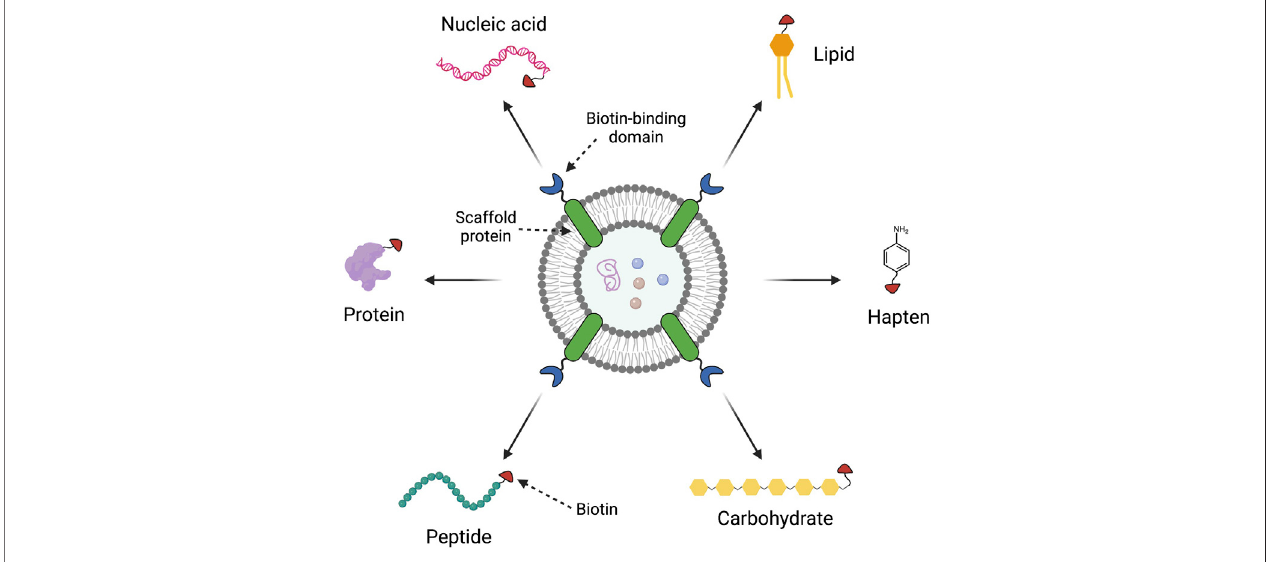
FIGURE 8 | The Addvax approach for external modi fi cation of outer membrane vesicles (OMVs). The Addvax approach, developed by Weyant et al. (2021), consists of a scaffold protein inserted into the OMV membrane that is fused to a biotin-binding domain, such as avidin. These avidin-decorated OMVs can then be reacted with any biotinylated compound, including proteins, peptides, carbohydrates, haptens, lipids, and nucleic acids, for conjugation to the OMV. This fi gure was generated using